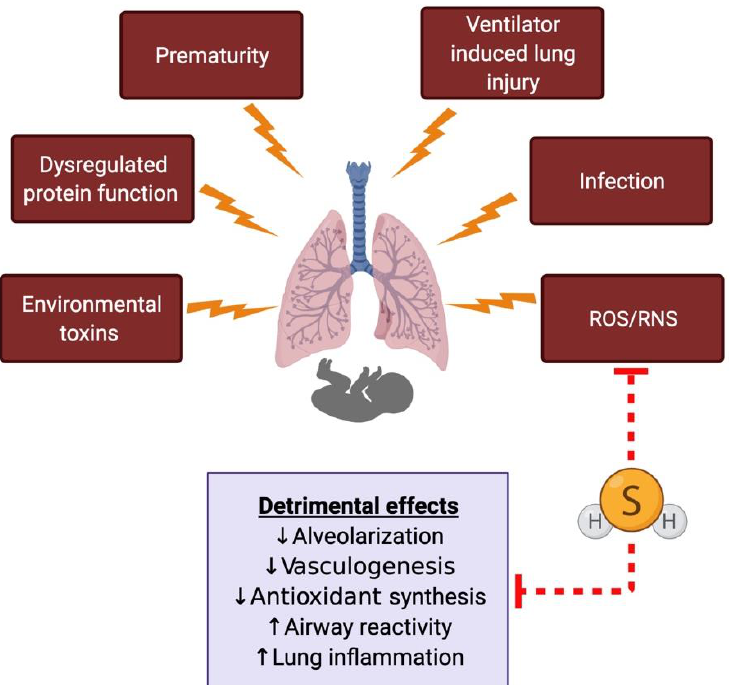
Figure 3. The proposed role of hydrogen sulfide (H 2 S) in the developing lung and neonatal respiratory diseases. The developing neonatal lung is subjected to different kinds of insults, leading to oxidative stress-related damage. H 2 S can directly scavenge free radicals and has been shown to prevent or reverse some of the detrimental effects in animal models of neonatal respiratory diseases. ROS, reactive oxygen species; RNS, reactive nitrogen species.